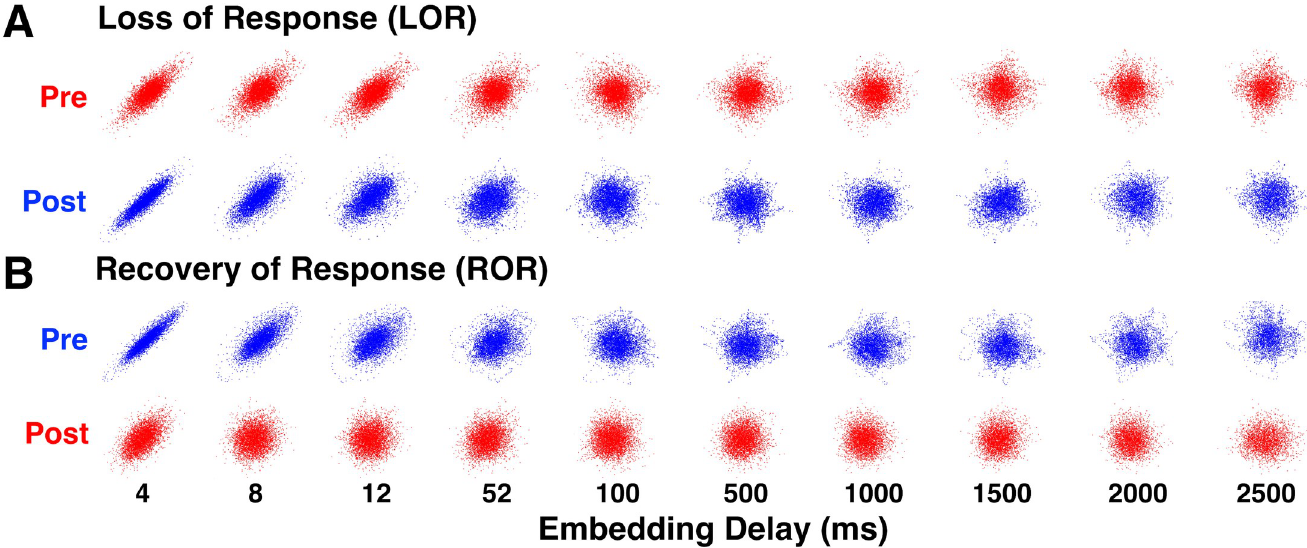
Fig 7. Attractors for loss and recovery of response change shape based on embedding delay. We plotted attractors from the 20 second windows we identified before and after LOR (A) and ROR (B) at a range of embedding delays. Note that the shape difference observed in the attractors disappears with increasing embedding delays. Examples are from patient D for both LOR and ROR.